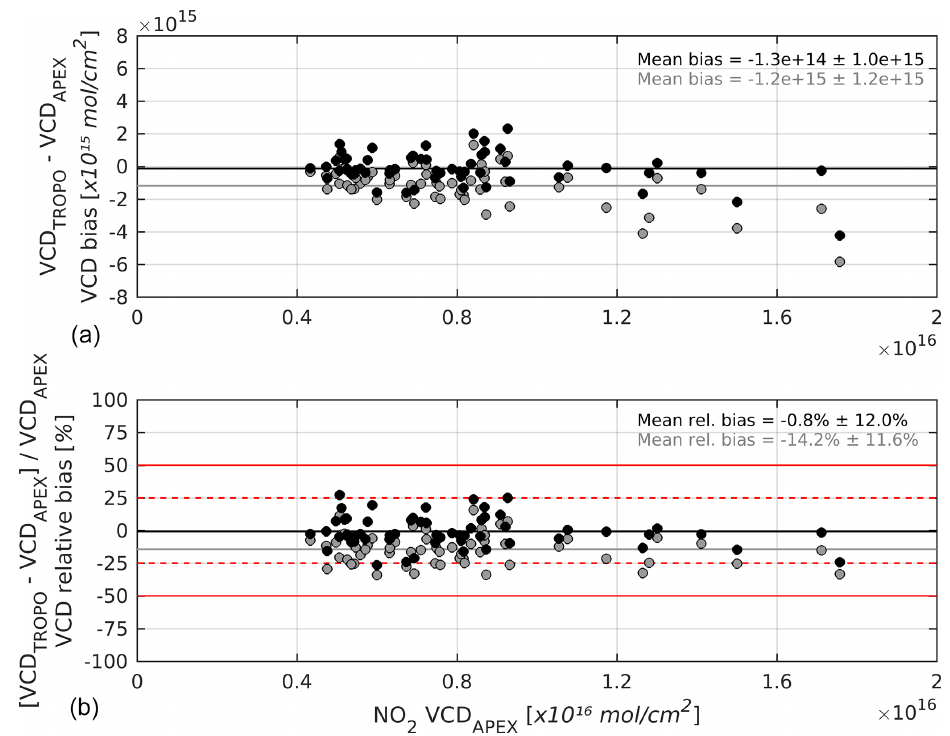
Figure 9. (a) NO 2 VCD bias (VCD TROPO ( − CRE ) − VCD APEX ) and (b) NO 2 VCD relative bias ((VCD TROPO ( − CRE ) − VCD APEX ) / VCD APEX · 100) for the ensemble of the four data sets, acquired during the S5PVAL-BE campaign. Data points and statistics are colour coded grey and black for the comparison of TM5-MP-based and CAMS-based TROPOMI VCD retrievals with APEX, respectively, in anal- ogy to Fig. 8. The grey and black horizontal lines represent the average (relative) bias. The dashed red and full horizontal lines represent the 25% and 50% bias between coincident TROPOMI and APEX NO 2 VCDs,